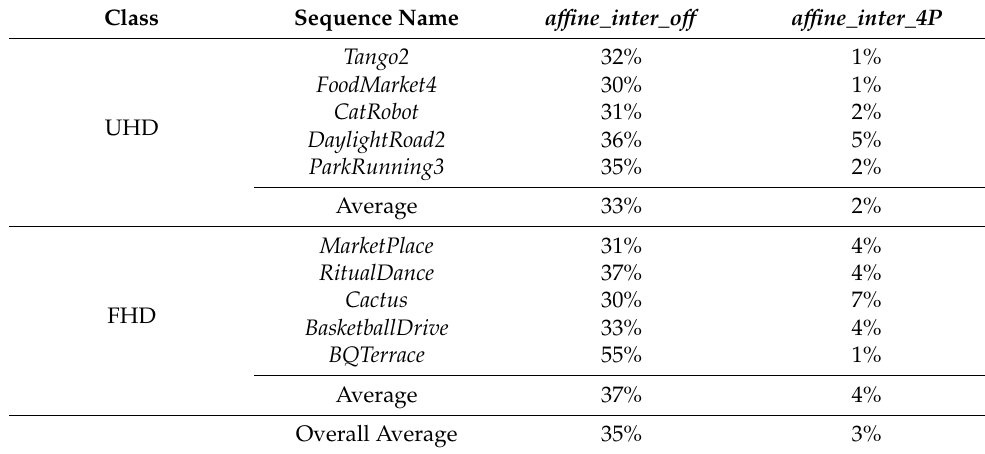
Table 7. Distribution of affine prediction by the proposed